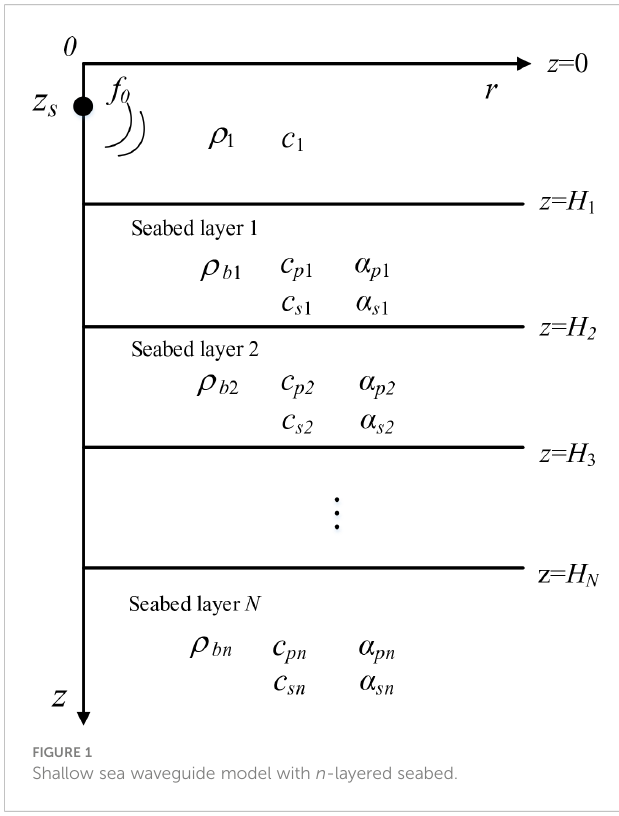
FIGURE 1 Shallow sea waveguide model with n -layered